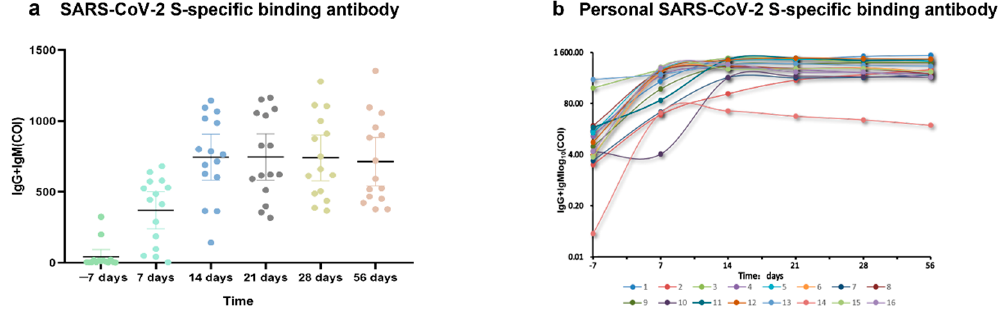
Figure 3. Time axes of samples collection and inoculation. － seven days, the seven days before the COVID ‐ 19 booster; seven days,14 days, 21 days, 28 days, and 56 days, The seven days, 14 days, 21 days, 28 days, and 56 days after the COVID ‐ 19 booster vaccine.